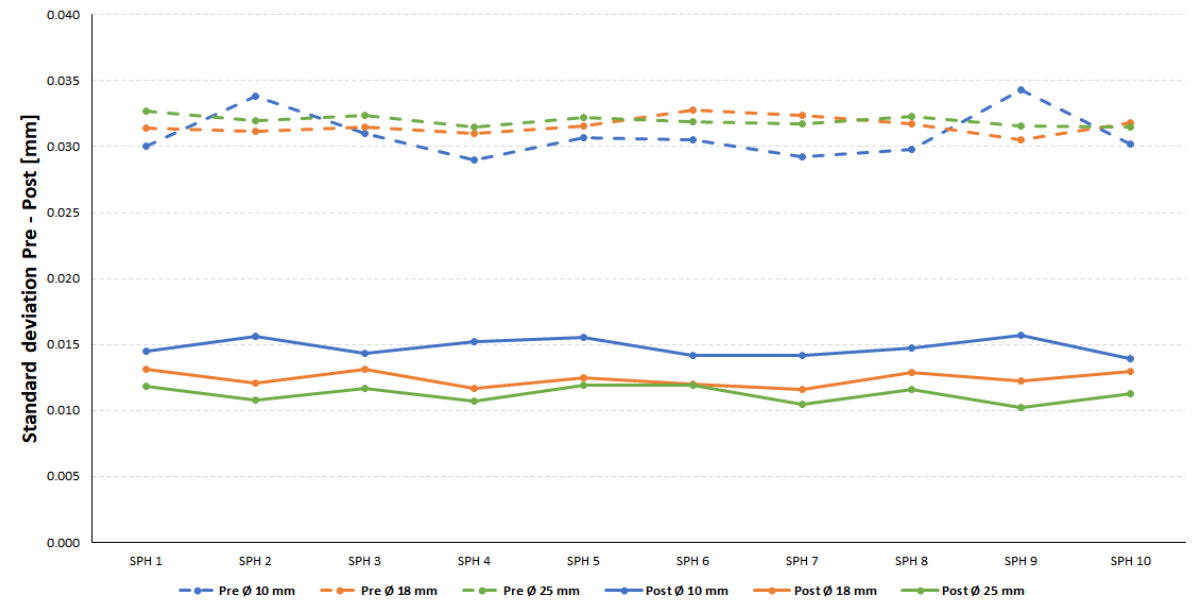
Figure 9. Standard deviation values pre- and post-sandblasting (laser measurements).